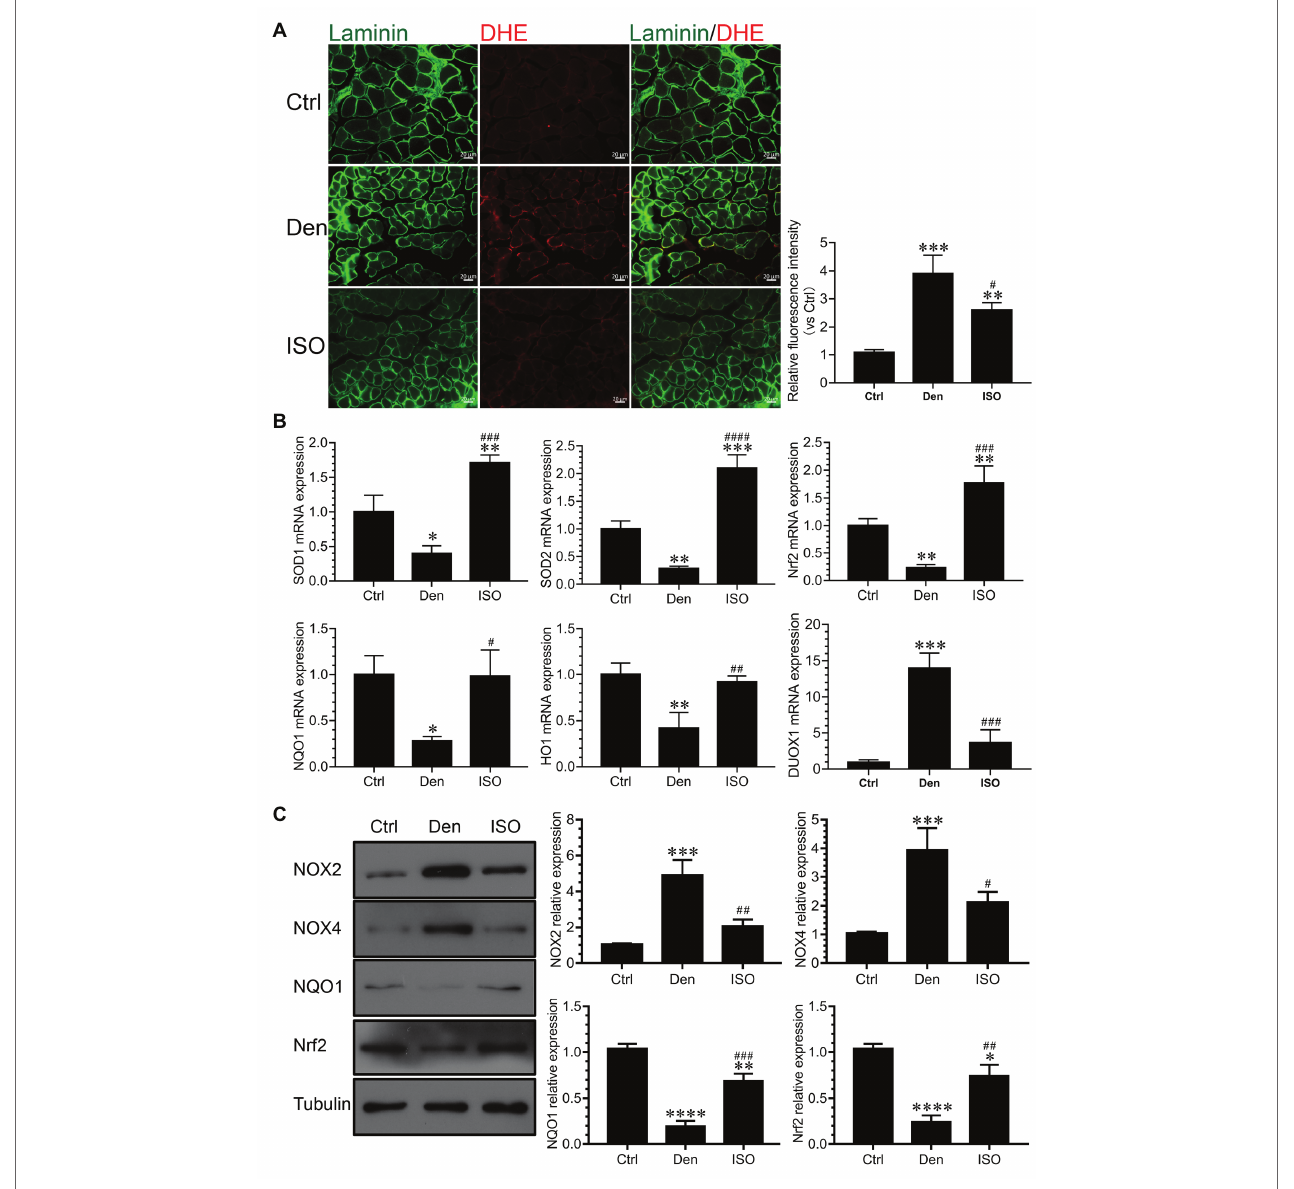
FIGURE 6 | Isoquercitrin inhibits oxidative stress in denervated soleus muscles ( n = 6). (A) Fluorescence diagram of reactive oxygen species (ROS) level and quantification of relative fluorescence intensity of each group in the dihydroethidium (DHE) probe detection experiment. (B) Quantitative polymerase chain reaction detection of the relative expression of antioxidant-related genes and ROS production-related genes. (C) Western blot of ROS-related and antioxidant-related proteins and quantification of the relative expressions. ROS, reactive oxygen species; Ctrl, control group; Den, denervation group; ISO, denervated target muscle plus isoquercitrin (20 mg/kg/d) group. * p < 0.05, ** p < 0.01, *** p < 0.001, and **** p < 0.0001 vs. Ctrl; # p < 0.05, ## p < 0.01, ### p < 0.001, and #### p < 0.0001 vs.